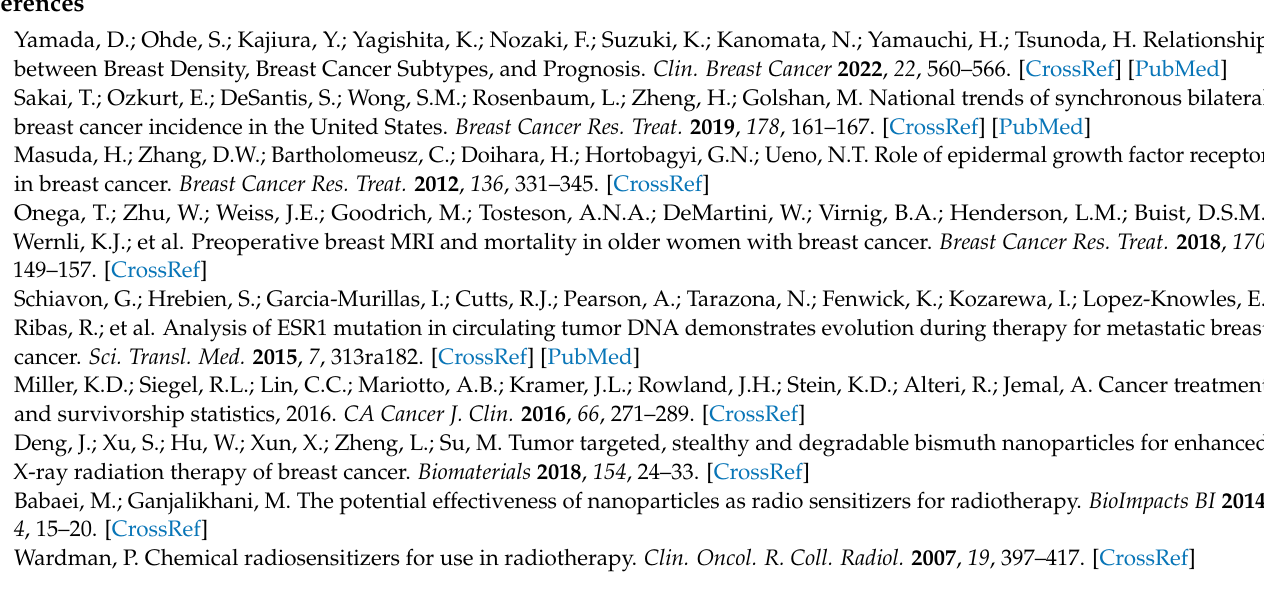
Figure S2: Representative SEM images of SAH. (Containing 0.01 mg/mL SFN); Figure S3: The